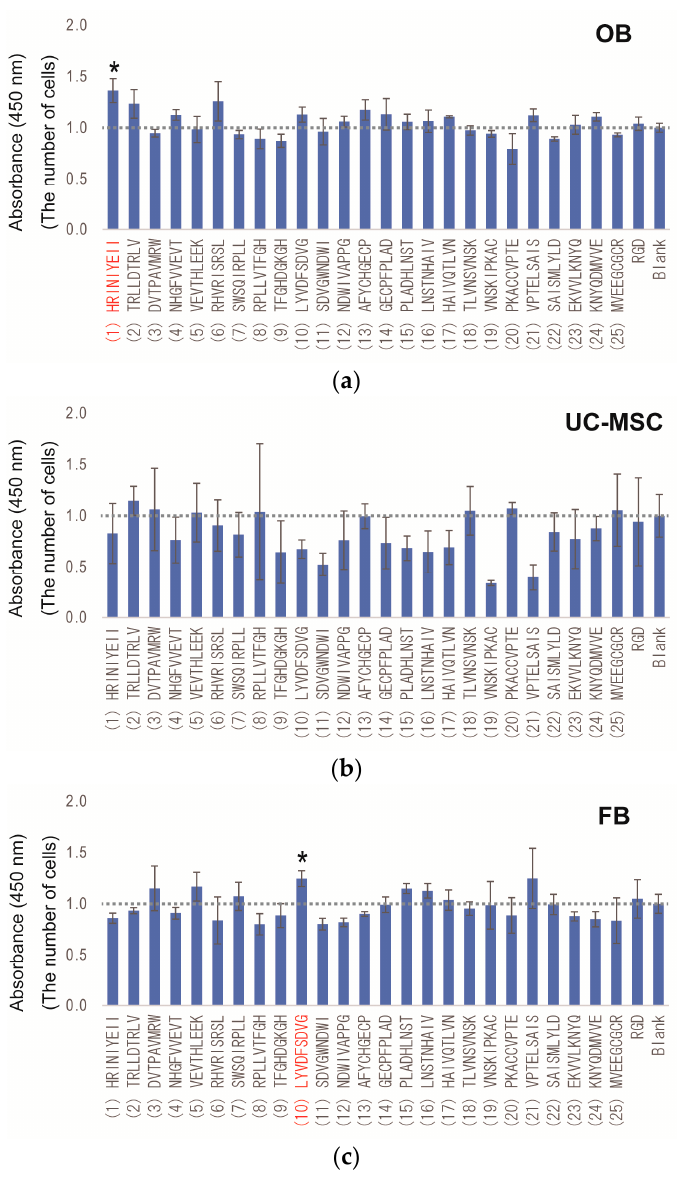
Figure 4. Results of the cell proliferation assay. The number of cells was calculated by the WST-8 assay at Day 7. The value was normalized to Blank (value of no peptide = 1.0). ( a ) OB; ( b ) UC-MSC; and ( c ) FB. All experiments were performed in triplicate. * Denotes statistical significance compared to Blank (no peptide), p < 0.05, Student’s t -test.